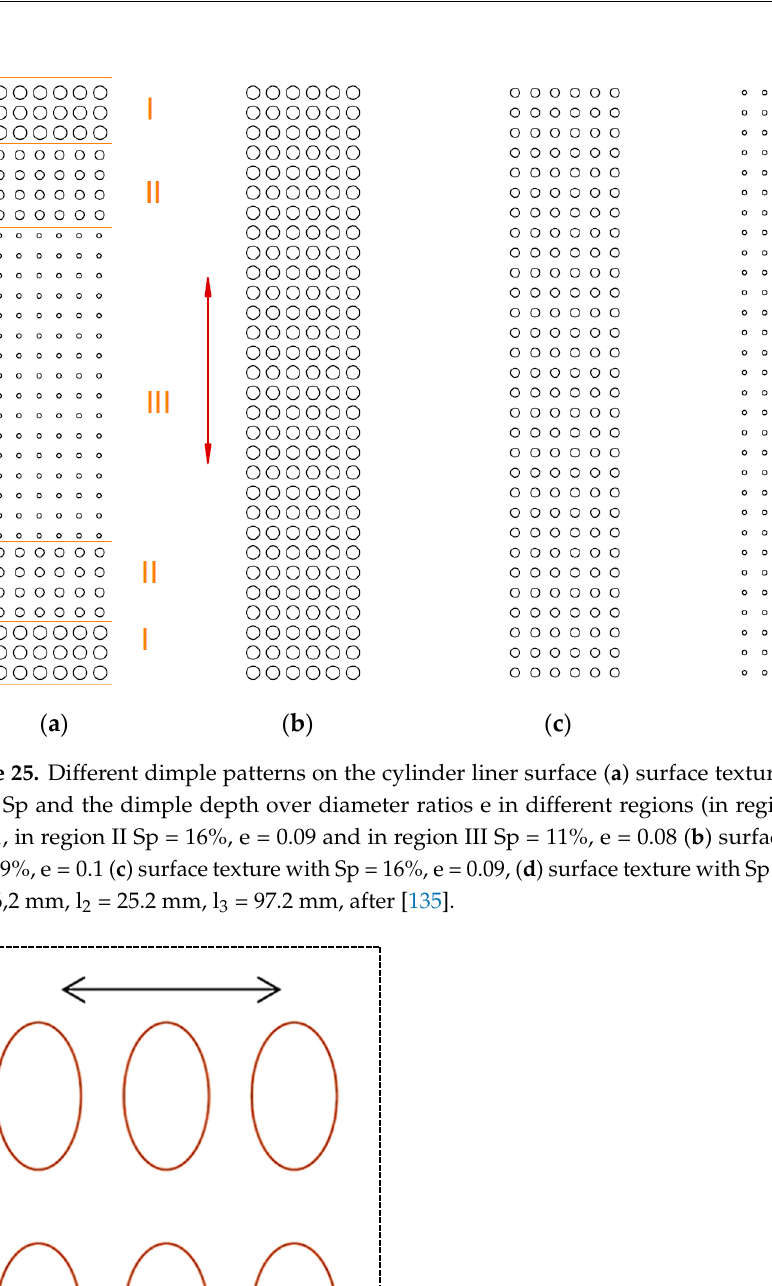
Figure 27. The scheme of contact between the cylinder liner and the piston ring, after [141]. Ma et al. [78] modeled the contact between the cylinder liners with micro-grooves and the piston ring. They studied hydrodynamic lubrication and contact between asper- ities. They analyzed the following dimple densities: 10, 25, and 50% with depth near 0.1 mm. The pit area ratio of 10% led to the greatest reduction in friction force. Parabolic and triangular grooves behaved better than rectangular ones. This model was validated by experiment. Zavos and Nikolakopoulos [142] analyzed full film lubrication between the cylinder and piston ring, and the contact of asperities was neglected. Wave-cut and honed cylin- der liners were modeled (Figure 28). Both types of cylinder texturing were found to cause